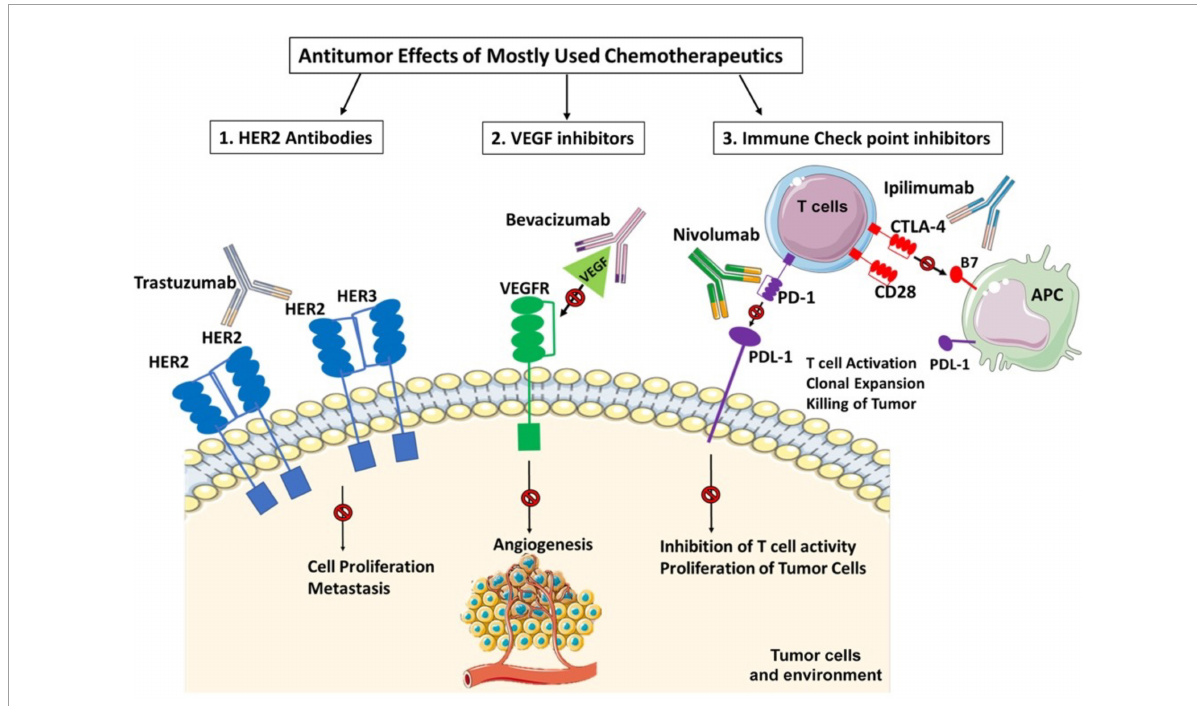
FIGURE5 Three widely used anticancer drug mediated cytotoxicity in cancer and heart. Clinically used targeted therapies/tyrosine kinase (TK) inhibitors mainly focuses on inactivation of heregulin receptor (HER2) or vascular endothelial factor (VEGF) signaling in cancers. HER2 signaling is important in heart and cancer. HER2 activation by its ligand heregulin stimulates proliferation pathway in the tumor cells. The inhibition of HER2 by its antibody, trastuzumab, in cancer cells blocks the cancer proliferation but in heart it blocks an important survival pathway in heart. Binding of VEGF to its receptors in endothelial cells activates angiogenesis. Inhibition of VEGF by its antibody, bevacizumab, can destroy the tumor angiogenesis and bring the tumor to avascular stage, whereas it can be detrimental in the heart due to reduced systemic angiogenesis. Indeed, the immunotherapy targeting cytotoxic T-lymphocyte antigen 4 (CTLA-4). anti-programmed cell death 1 (PD1) or its receptor (PDL-1) relies on cancer destruction through the activation of the host immune system. However, PD-L1 is also expressed in the non-immune cells to maintain self-tolerance. Nivolumab and Ipilimumab activate T cells and promotes T cell clonal expansion to kill tumor cells. However activated T cells also recognize shared antigens and destroy cardiomyocytes as